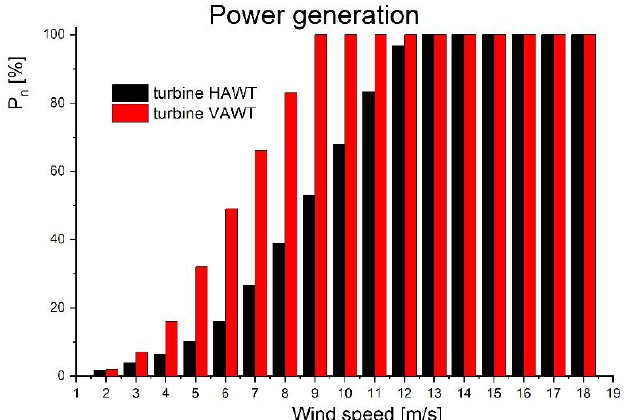
Figure 8. Distribution of average monthly wind in the area of the fish production plant at the height of 60 and 30 m.